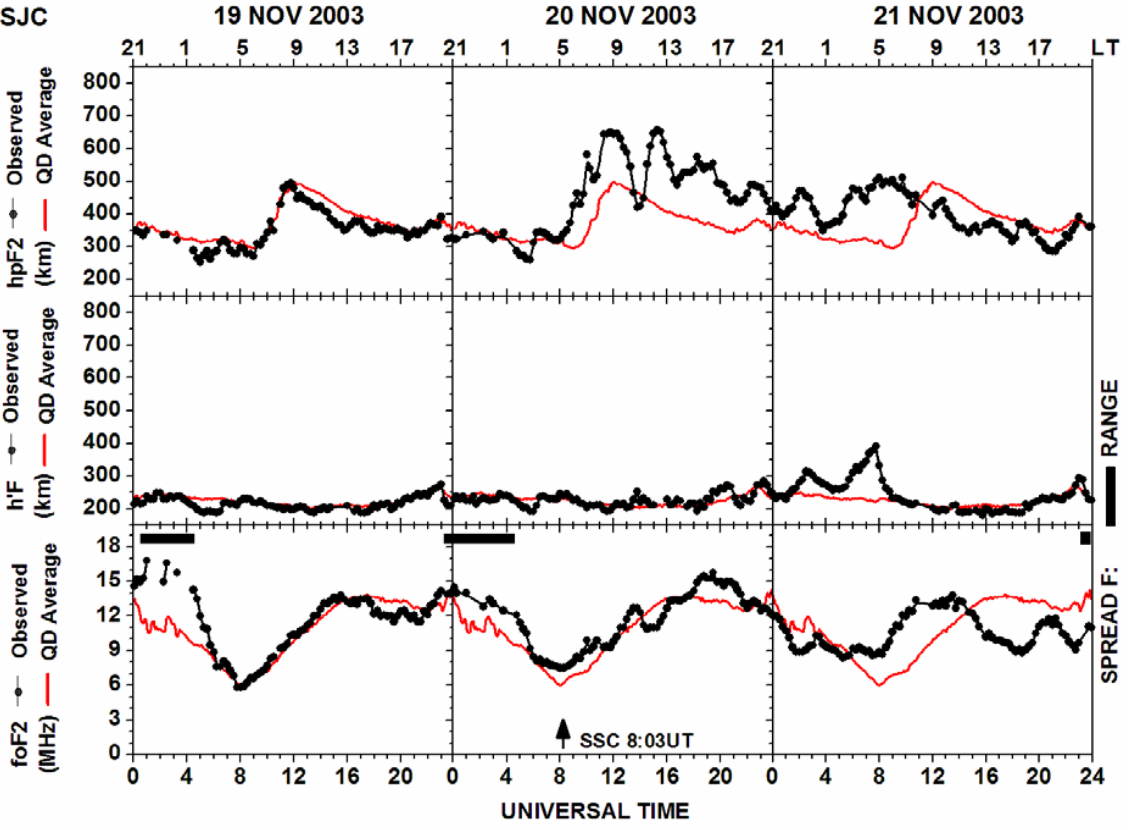
Fig. 4. Same as in Fig. 3, but for Sao Jose dos Campos (SJC),